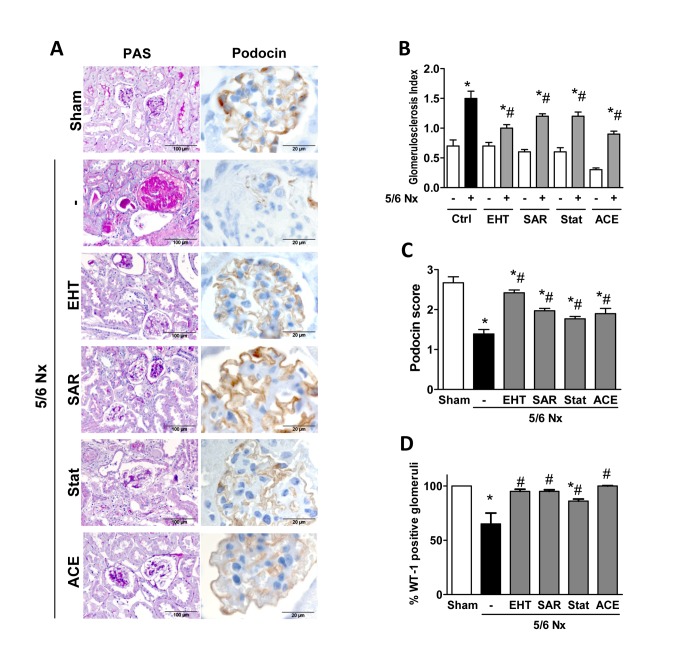
GTPase inhibition attenuates 5/6Nx-induced renal histological changes.Representative PAS (left panel; scale bar 100 µm) and podocin (right panel;, brown color, scale bar 20 µm) stained kidney sections (A), glomerulosclerosis index (B), podocin staining quantification (C), and percentage of WT-1 positive stained glomeruli (D) in kidneys from sham and 5/6Nx mice non-treated or treated with EHT, SAR, statin and ACE inhibitors. Data represent means ± SEM. *P<0.05 vs. corresponding sham control (n=5-7 for sham and n=8-18 for 5/6Nx mice); # P<0.05 vs. 5/6Nx non-treated mice (n=9-18).